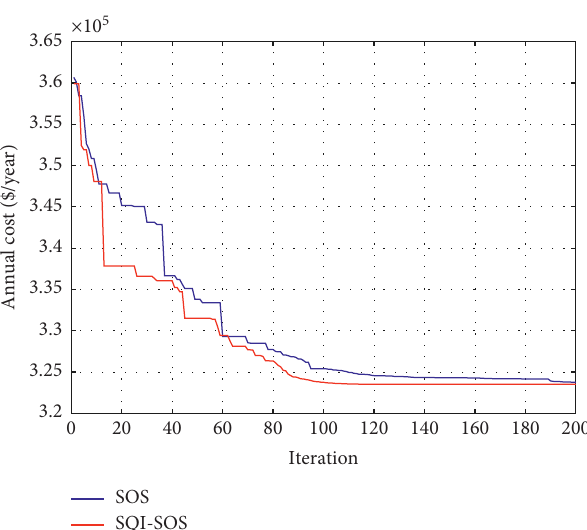
Figure 16: Convergence curves of the total cost of the 119-bus system with the CP load model at 100%